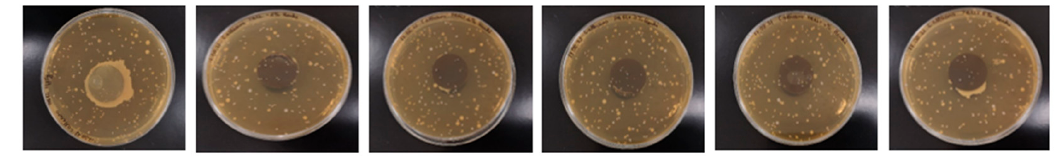
Figure A3. Comparison of E. coli growth in contact with PA12 and PA12 + 1–5 wt % oxides.